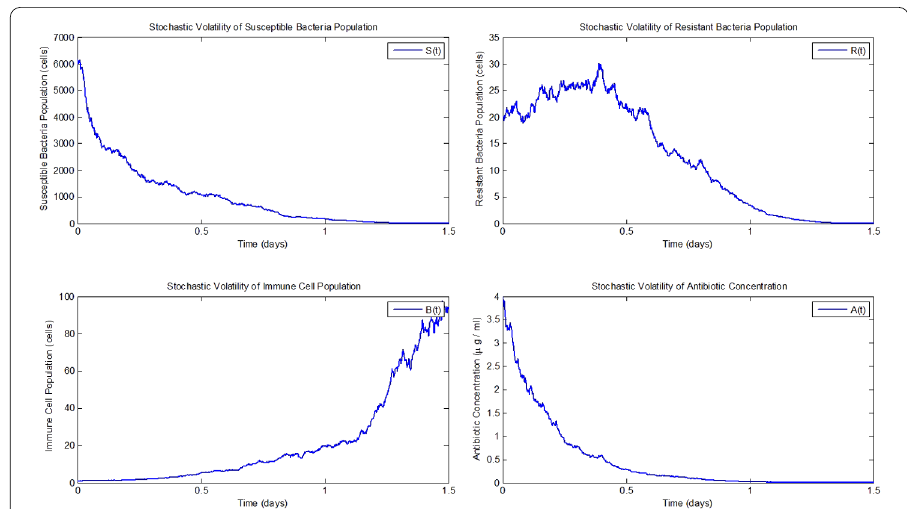
Figure 9 Realizations of the approximate solutions of the stochastic model.